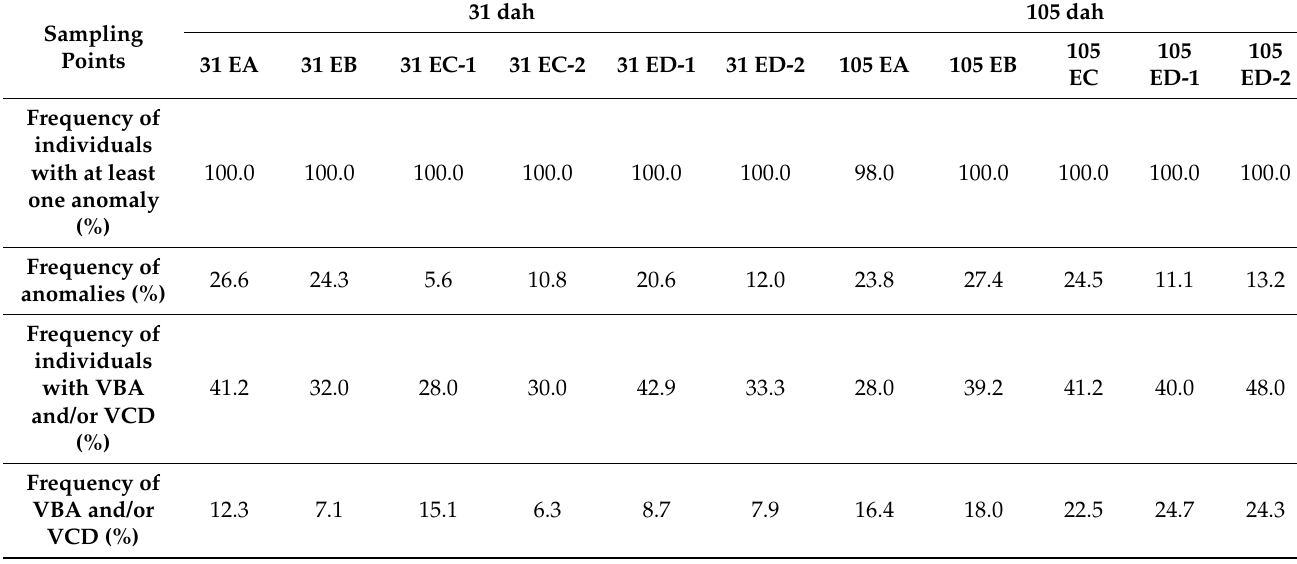
Table 9. General results on the incidence of skeletal anomalies for each group (31 EA, 31 EB, 31 EC-1, 31 EC-2, 31 ED-1, 31 ED-2, 105 EA, 105 EB, 105 EC, 105 ED-1, 105 ED-2): frequency of individuals displaying at least one anomaly (%); frequency of skeletal abnormalities with respect to the total number of anomalies observed in each age group; frequency of individuals with vertebral body anomalies (VBA) and/or vertebral column deviations (VCD) (%); percentage of VBA and/or VCD in the total number of anomalies of that diet-tank-age group.